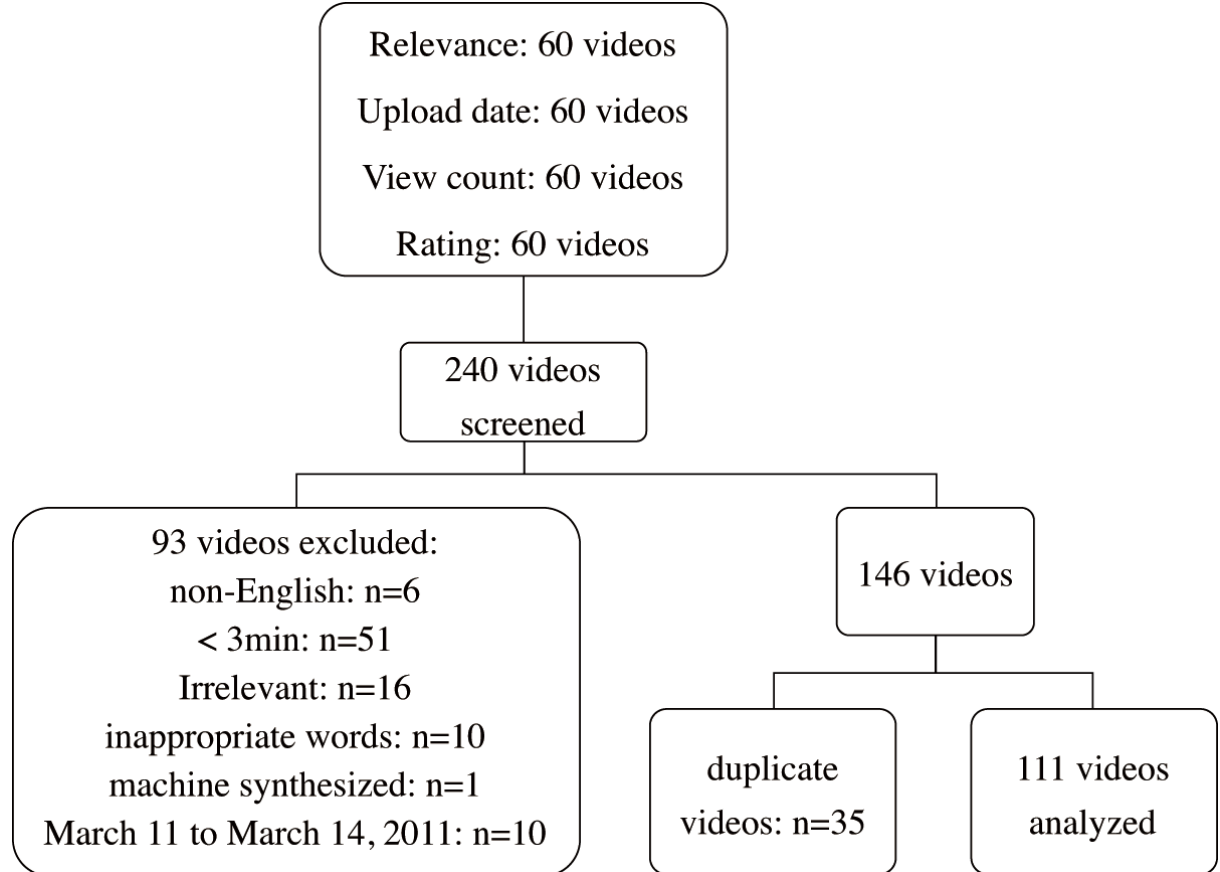
Figure 1. Flowchart showing the systematic video search and selection processes.